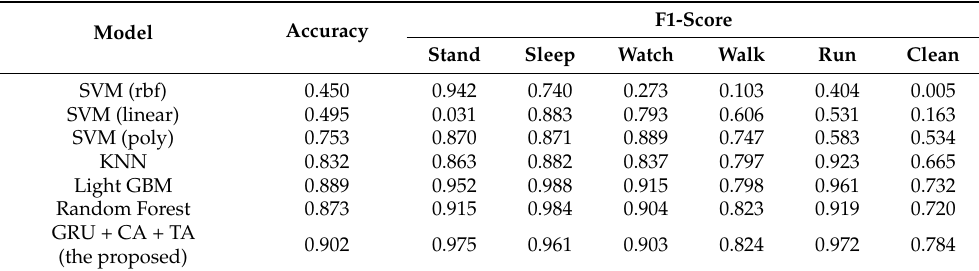
Table 5. Comparison experiments of different models on the datasets without I.I.D.